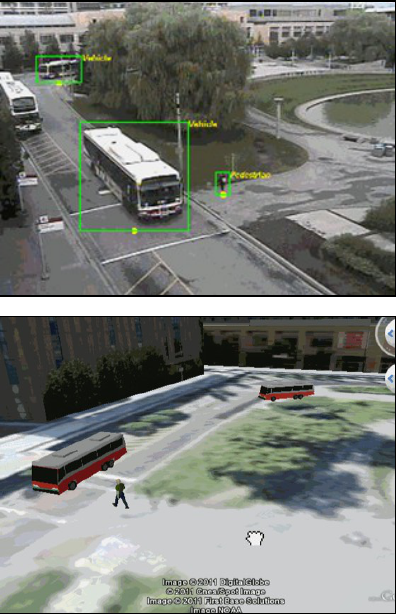
Figure 1. 3D surveillance prototype. Top: Moving image objects detected from surveillance video. Bottom: 3D visualization of detected objects in Google